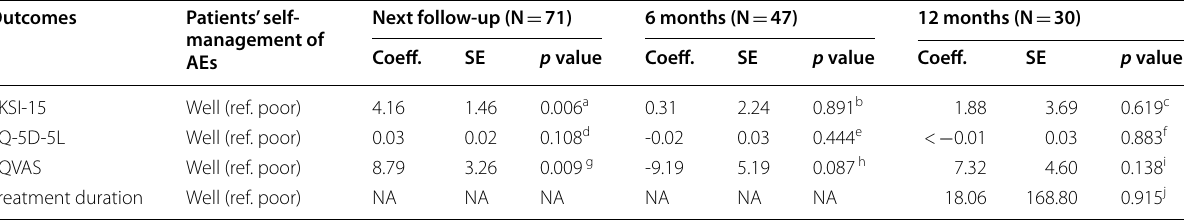
The p values of ‘a to i’ were estimated using sequential conditional mean models, adjusted with the following variables other than the fixed confounding variables, presenting R squares which mean each explanatory power of the models: a FKSI-15 and ECOG PS at baseline, R 2 78%; b FKSI-15 at next follow-up, treatment duration, = disease duration, ECOG PS at baseline and 6 months, and metastasis site at 6 months (bone), R 2 65%; c FKSI-15 at 6 months, disease duration, ECOG PS at 6 months = and 12 months, and intervention schedule change at 12 months, R 2 76%; d EQ-5D-5L at baseline, BMI, histology, ECOG PS at baseline, and metastasis site at baseline = (bone, brain, and pancreas), R 2 72%; e EQ-5D-5L at next follow-up and metastasis site at 6 months (lung, bone), R 2 60%; f EQ-5D-5L at 6 months, metastasis site at = = 6 months (LN), and ECOG PS at 12 months, R 2 85%; g EQVAS at baseline, BMI, and metastasis site at baseline (bone, LN, brain), R 2 65%; h EQVAS at next follow-up, = = BMI, disease duration, operation, and metastasis site at baseline (lung) and at 6 months (bone), R 2 65%; and i EQVAS at 6 months, disease duration, metastasis site at = 12 months (LN, bone), and response criteria at 12 months, R 2 =